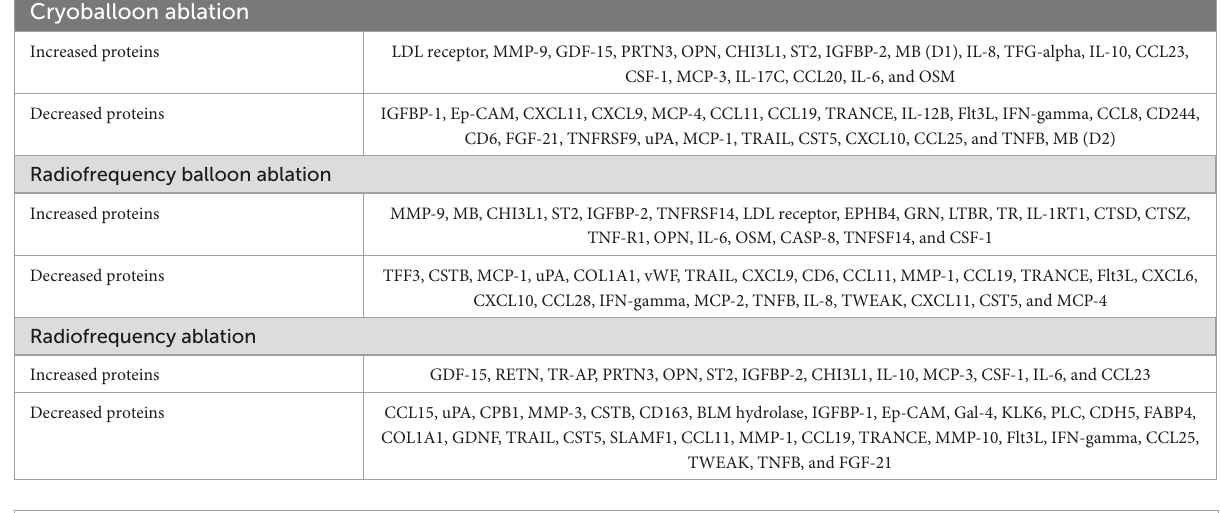
TABLE 2 Significantly altered proteins before and after ablation were sorted by three different techniques.